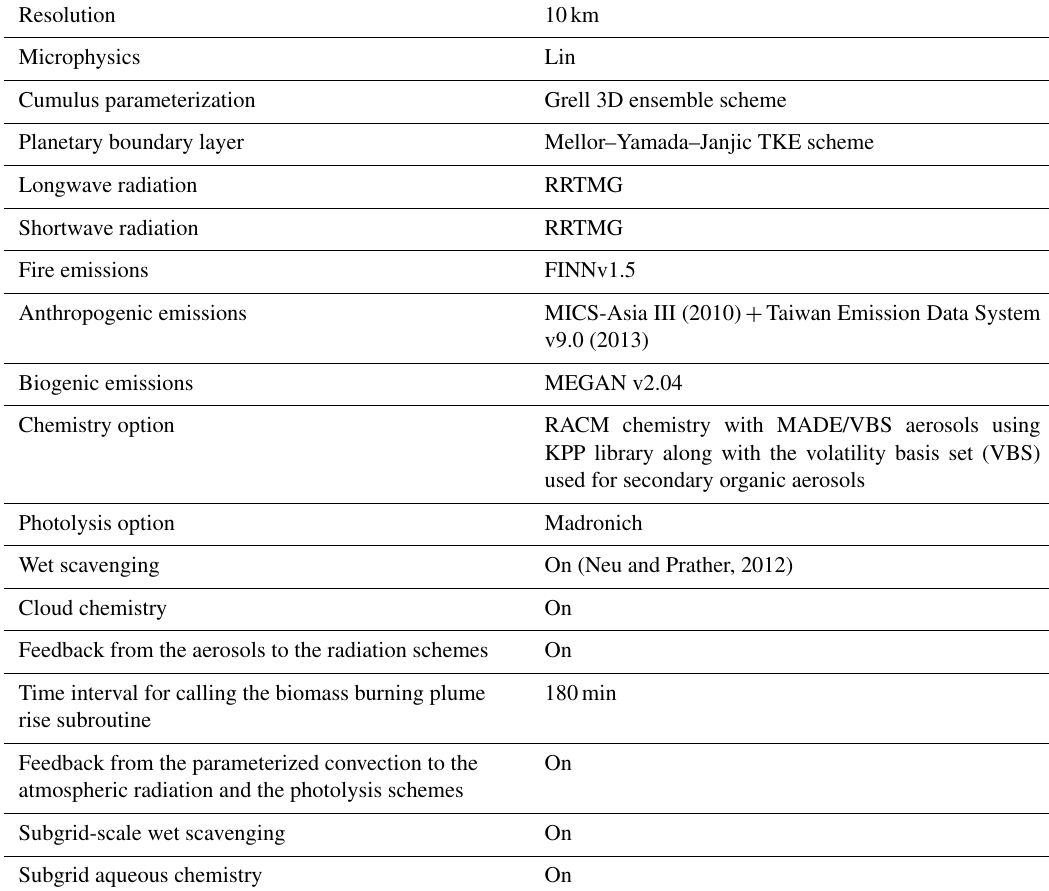
Table 1. WRF-Chem model configuration and physics and chemistry options in this study (rapid radiative transfer model for general circu- lation models: RRTMG; Fire Inventory from National Center for Atmospheric Research: